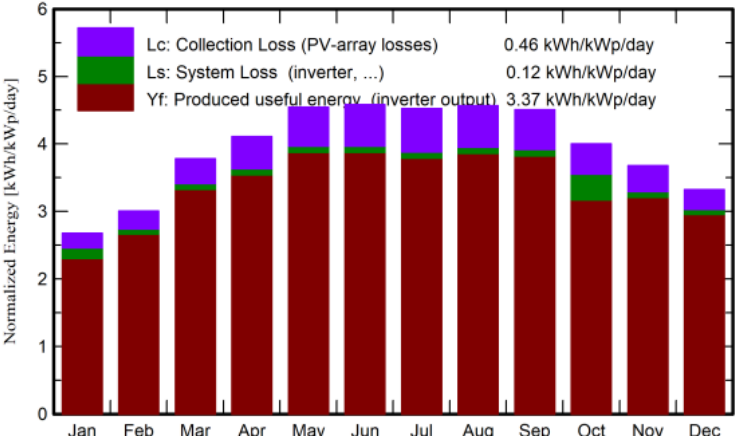
Figure 13. Monthly electricity of simulation results of IES according to NASA data.